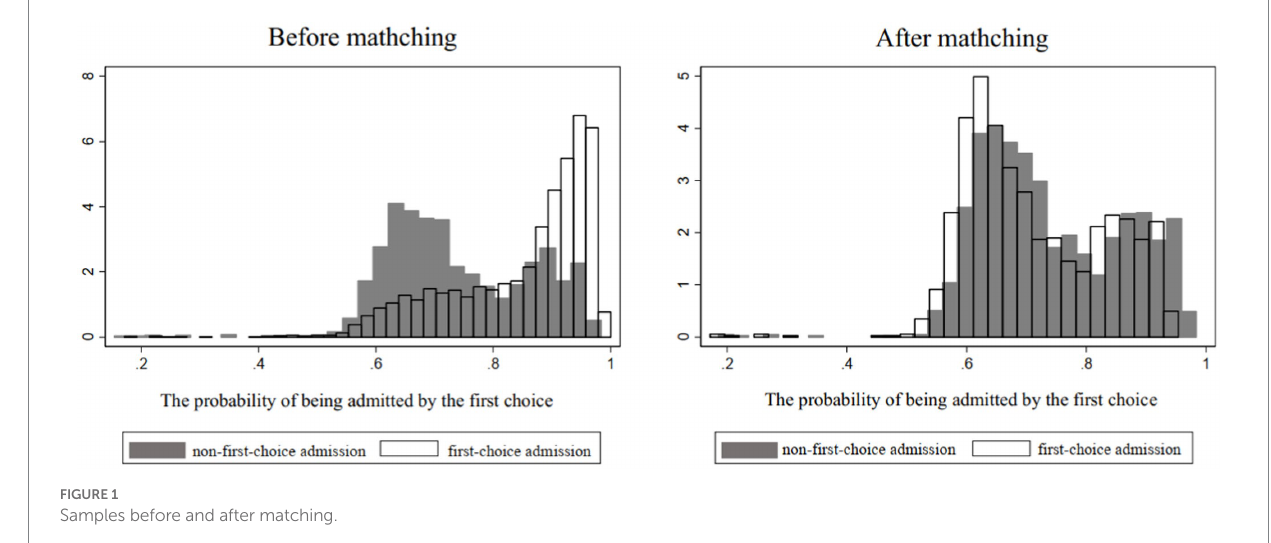
FIGURE 1 Samples before and after